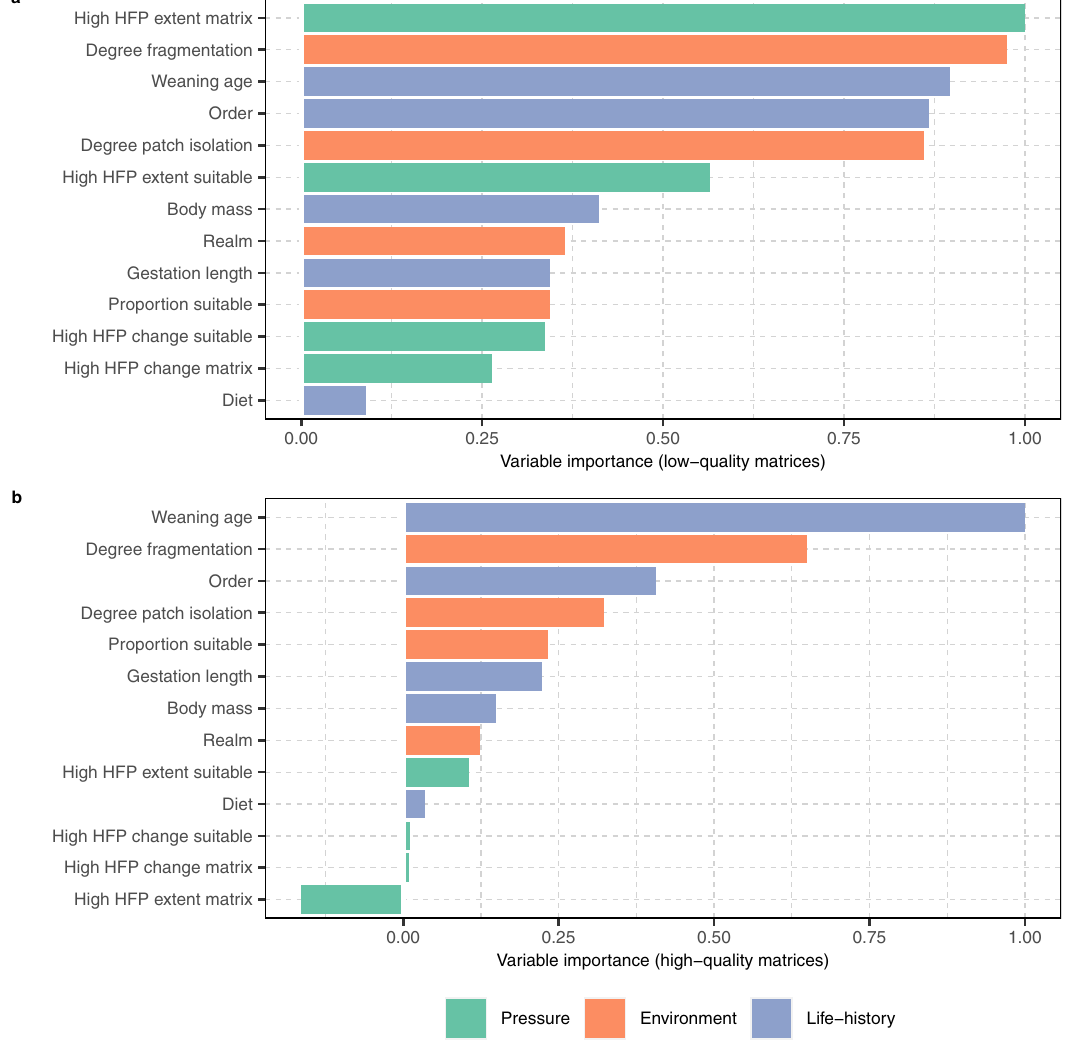
Fig. 4 In fl uence of the matrix condition on the relative importance of selected variables for the prediction of extinction risk transitions in terrestrial mammals. a Relative importance of each predictor for species with a low-quality matrix, which included proportions >84.2% of the extent of their matrix overlapping with high human footprint values ( n = 1815 low-risk species and 1027 high-risk species). b Relative importance of each predictor for species with a high-quality matrix, which included proportions <15.8% of the extent of their matrix overlapping with high human footprint values ( n = 60 low-risk species and 29 high-risk species). Variables are colour-coded according to their broad class (human pressure, environment, and life-history). The description of each variable is given in Table 1. High levels of the human footprint (HFP) included values of 3 or above. Source data are provided as a Source Data fi